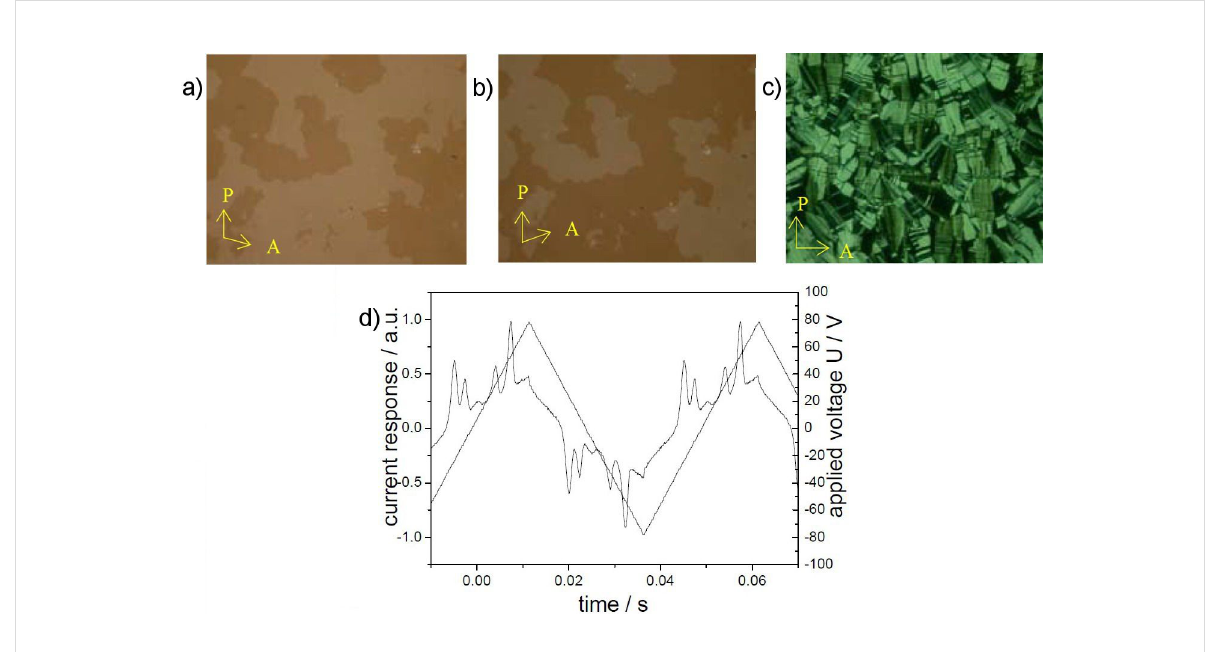
Figure 20: Compound OH 5b: a), b) Chiral domains at 175 °C, 0 V, polarisers uncrossed by about ±8° from the 90° position; c) birefringent texture formed under an electric field ( U = 100 V A.C. ); d) current response ( U = 158 V pp , f = 20 Hz, T = 174 °C, d cell = 6 μ